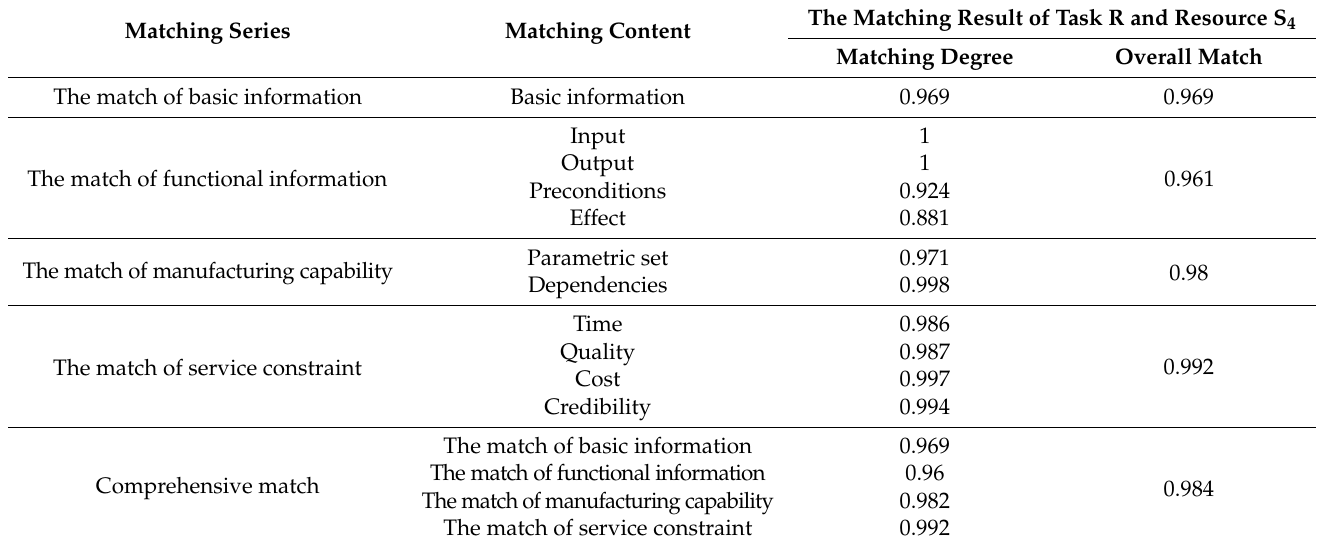
Table 3. Results of the task for manufacturing a battery temperature sensor that matches the resource S 4